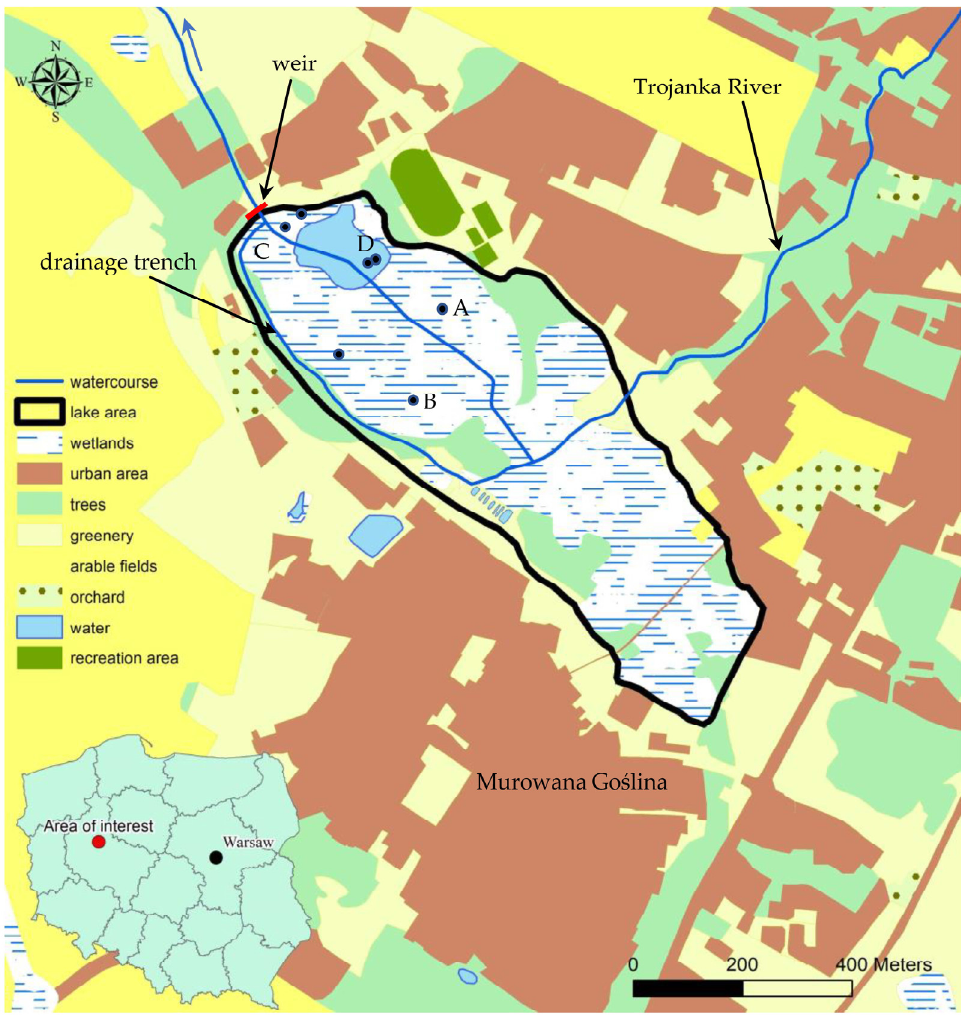
Figure 1. Location of the Raduszyn Lake. Explanation: A–D—sampling sites.